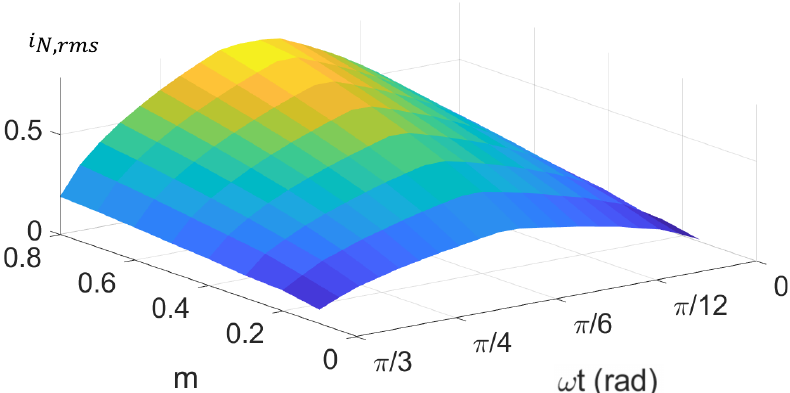
Figure 11. Neutral-point current (rms) of the proposed hybrid modulation for unity power factor in the first Sector.